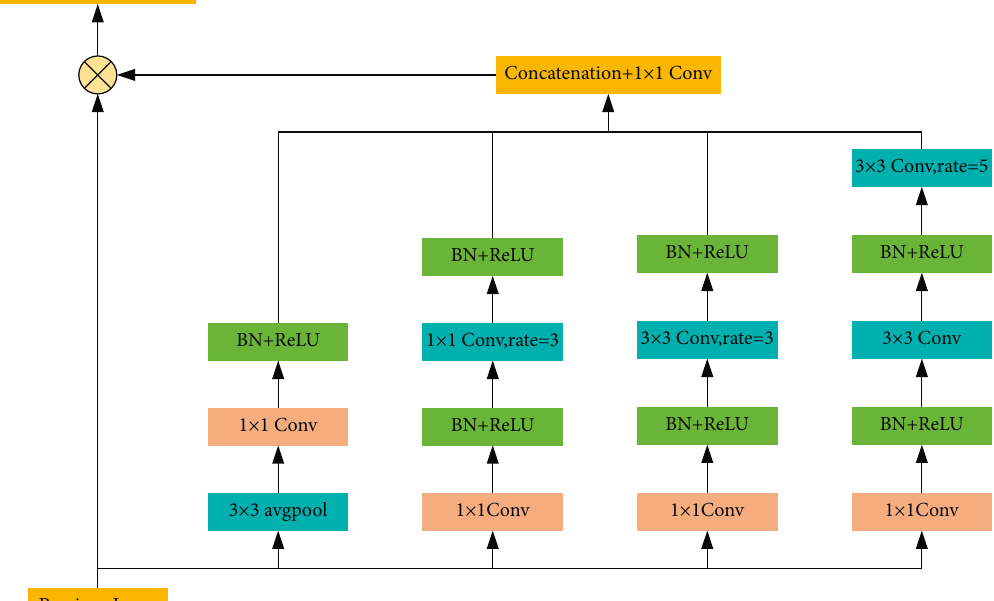
Figure 1: Improved concept module network